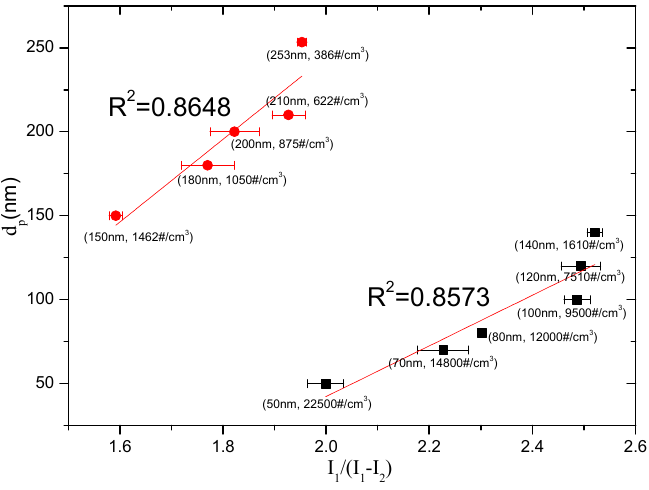
Figure 5 . The relationship between (cid:1856) (cid:3043) and (cid:1835) (cid:2869) /((cid:1835) (cid:2869) − (cid:1835) (cid:2870) ) for testing monodisperse aerosols with number concentrations in the range of 300 – 2.5 × 10 4 /cm 3 .